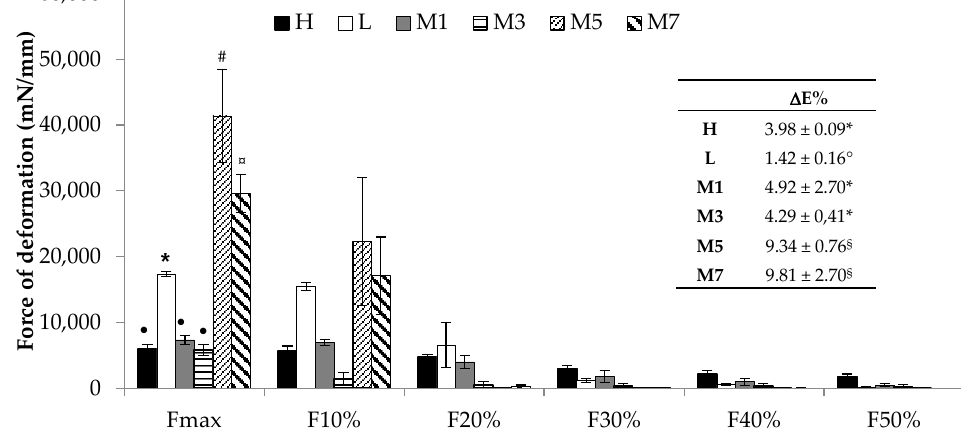
Figure 10. Mechanical properties of H, L, M1, M3, M5, and M7 fibers: maximum force of deformation and forces measured at different deformation values are reported (mean values ± SE; n = 3). Different symbols indicate statistically different data ( p < 0.05; one-way ANOVA; Multiple Range Test). In the inset, elongation at break ( ∆ E%) values of electrospun fibers obtained from H, L, and M solutions are reported (mean value ± SE; n =